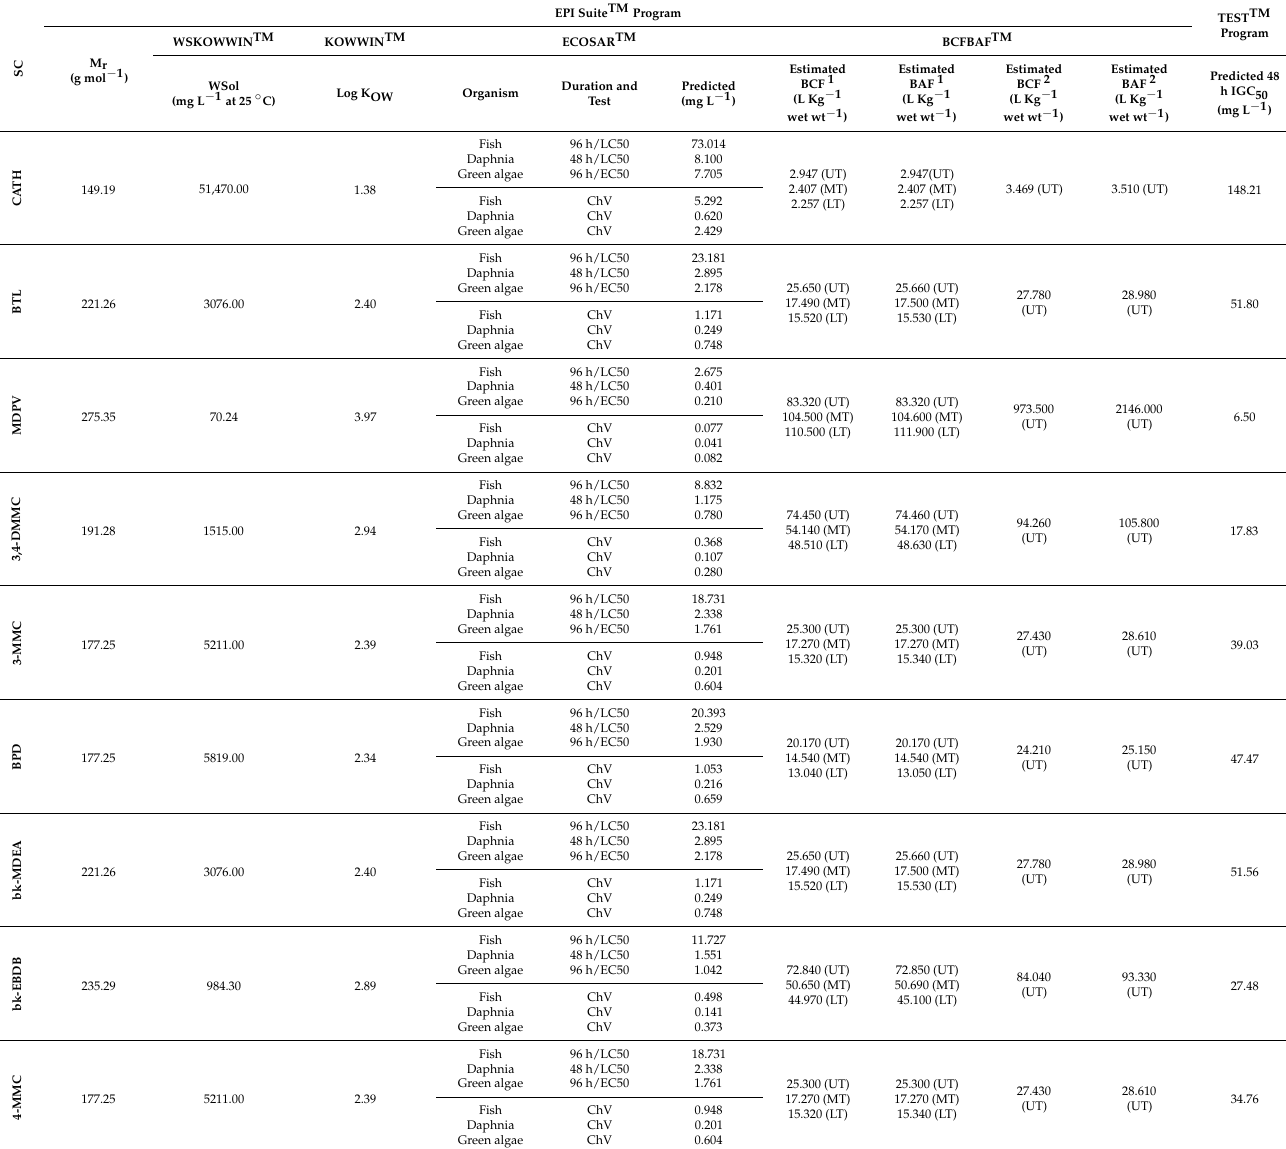
Table 1. Predicted physical-chemical properties (i.e., WSol and log K OW ) and toxicity data for 44 SC using EPI Suite TM program (green algae, daphnia, and fish) and TEST TM program (protozoan, Tetrahymena pyriformis